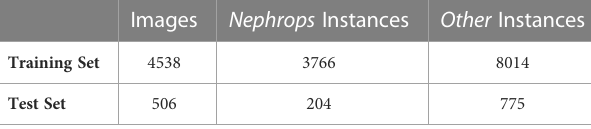
TABLE 2 Numbers of images and instances from both classes in the training and test sets used in the object detection